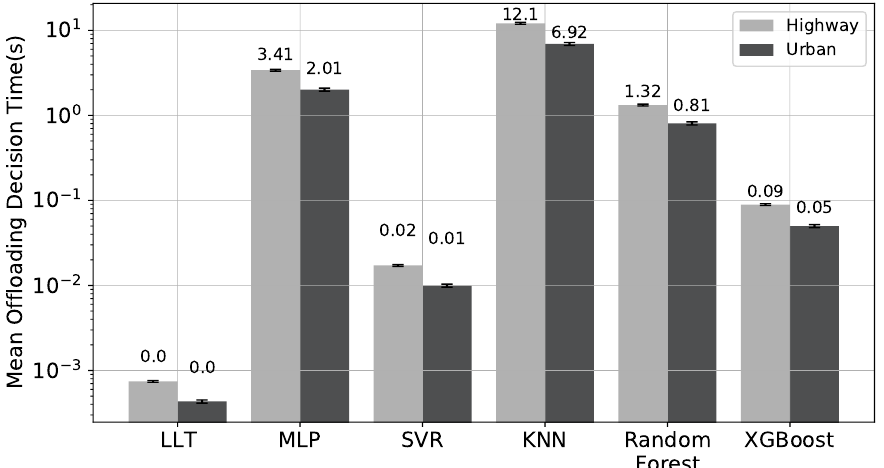
Figure 6. Offloading decision time for the evaluated